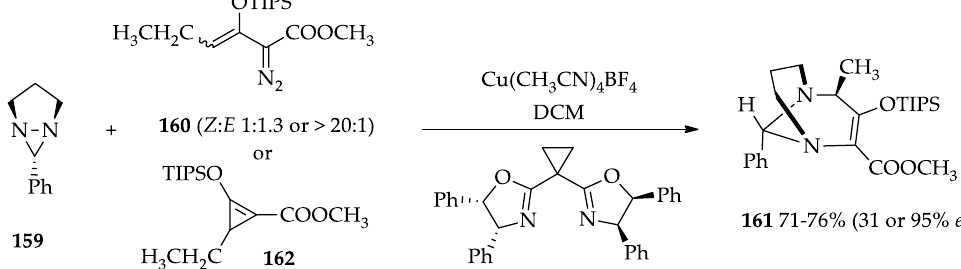
Figure 20. Bicyclic diaziridine 154a−v reaction with donor–acceptor cyclopropanes 155 . Conditions: (i) Ni(ClO 4 ) 2 ·6H 2 O, MS 4Å , CH 2 Cl 2